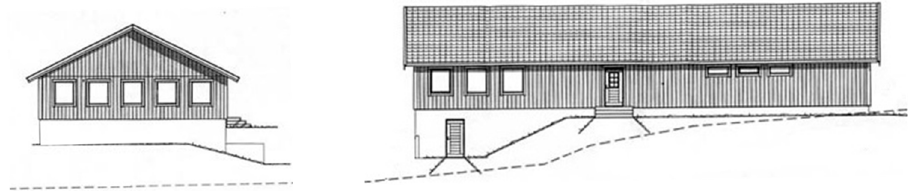
Figure 2. Side and front elevations of the clubhouse building.